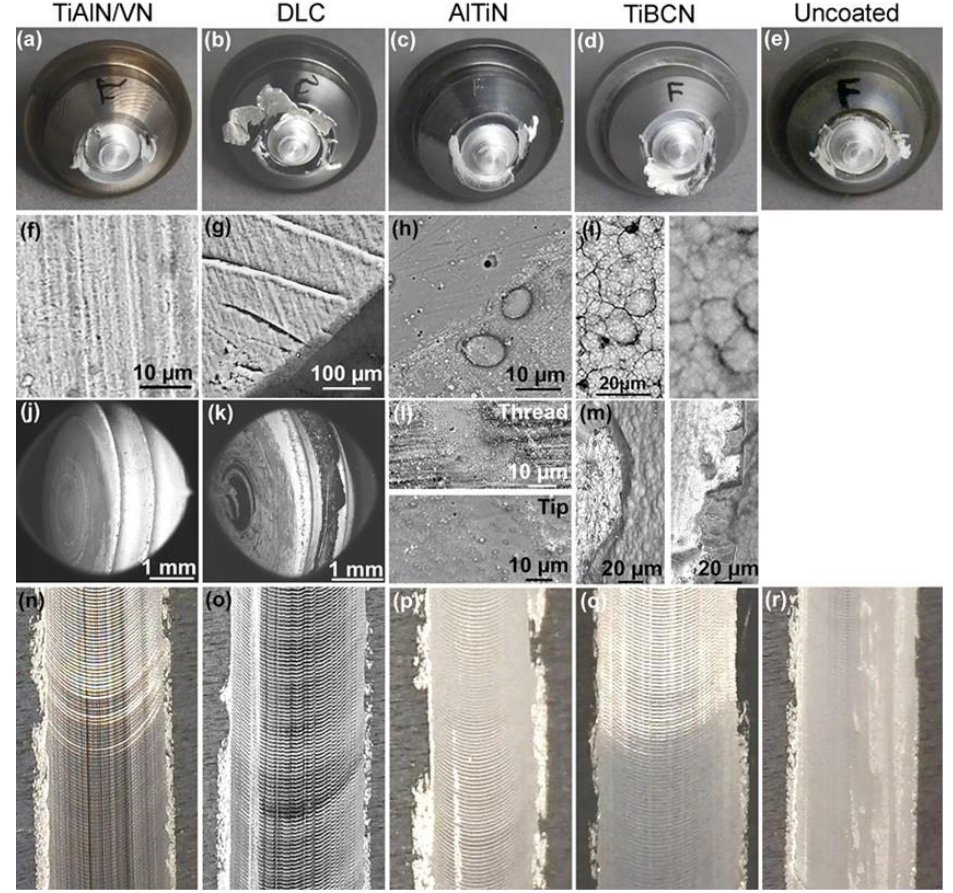
Figure 13. Post-welding analysis. Photographs of the shoulders after welding for tools coated with ( a ) TiAlN/VN, ( b ) DLC, ( c ) AlTiN, ( d ) TiBCN, and ( e ) uncoated tools. SEM micrographs of the trailing edge of the shoulders near the contact area after welding and chemical etching with NaOH, for tools coated with ( f ) TiAlN/VN, ( g ) DLC, ( h ) AlTiN, and ( i ) TiBCN showing surface adjacent to the contact area (left) and inside the contact area (right). Micrographs of the probes coated with ( j ) TiAlN/VN, ( k ) DLC, ( l ) AlTiN, and ( m ) TiBCN. Weld surfaces produced by tools coated with ( n ) TiAlN/VN, ( o ) DLC, ( p ) AlTiN, and ( q ) TiBCN and ( r ) uncoated tools.